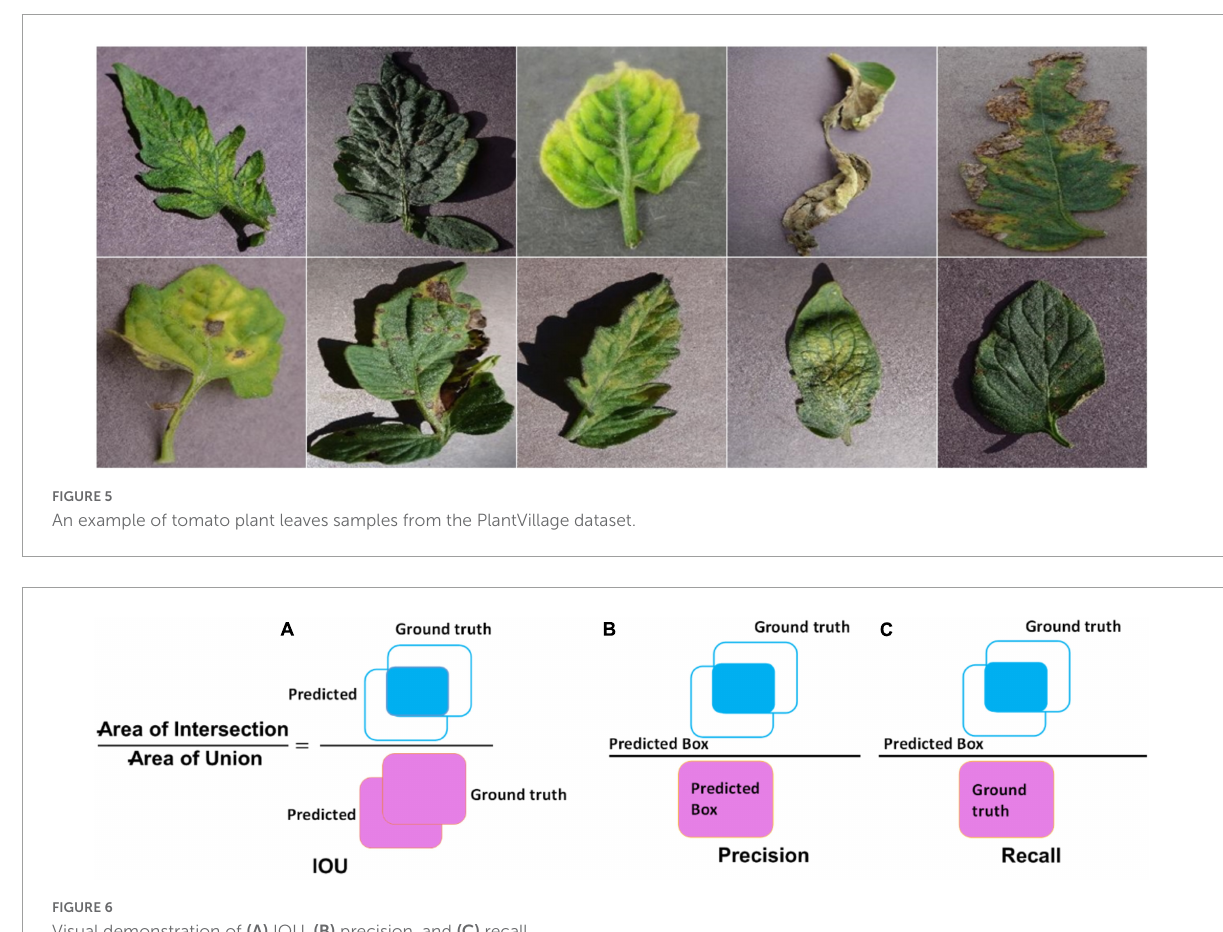
Figure 10 . The custom CornerNet model attains the average F1- score of 99.57% with the maximum and minimum error rates of 0.23 and 0.82%, respectively. The reported values